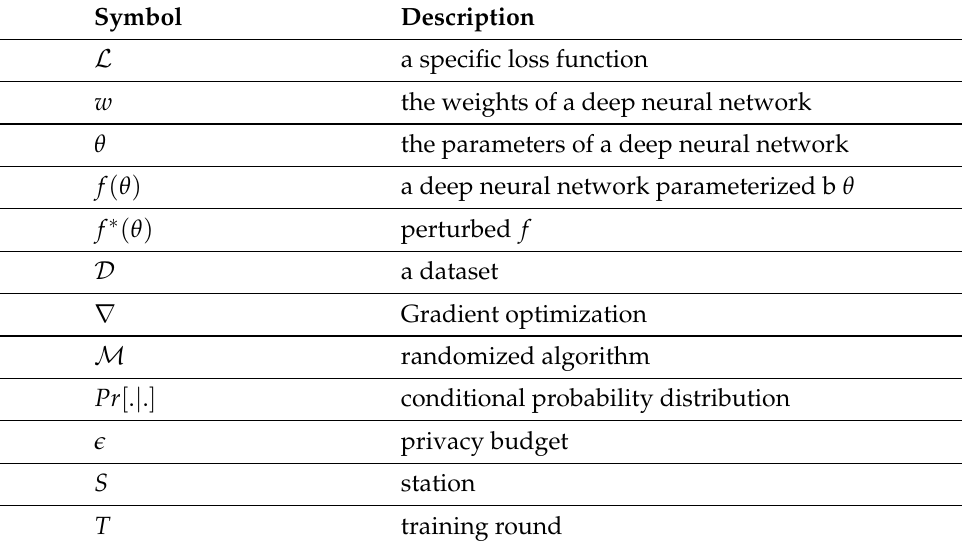
Table 1. Summary of symbol